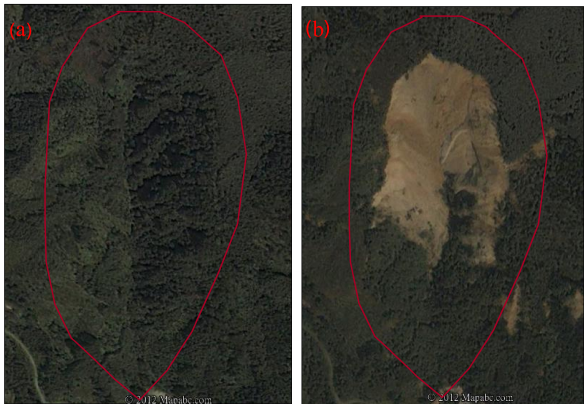
Figure 3. The Guojuanyan gully before (a) and after (b) the Wenchuan earthquake (from Google